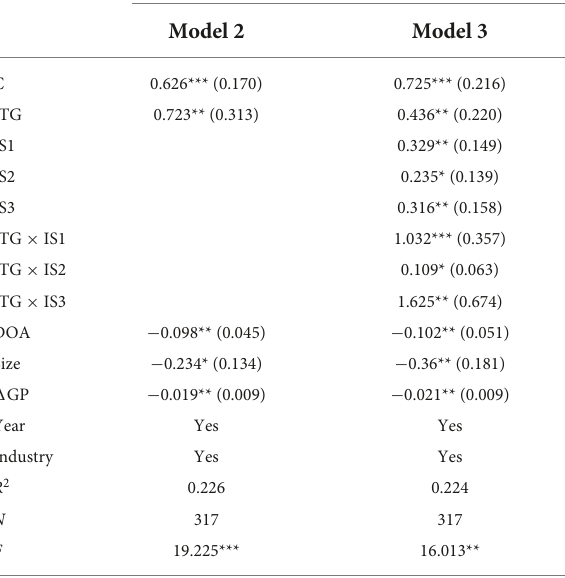
TABLE 8 Information strategy, IT governance, and firm